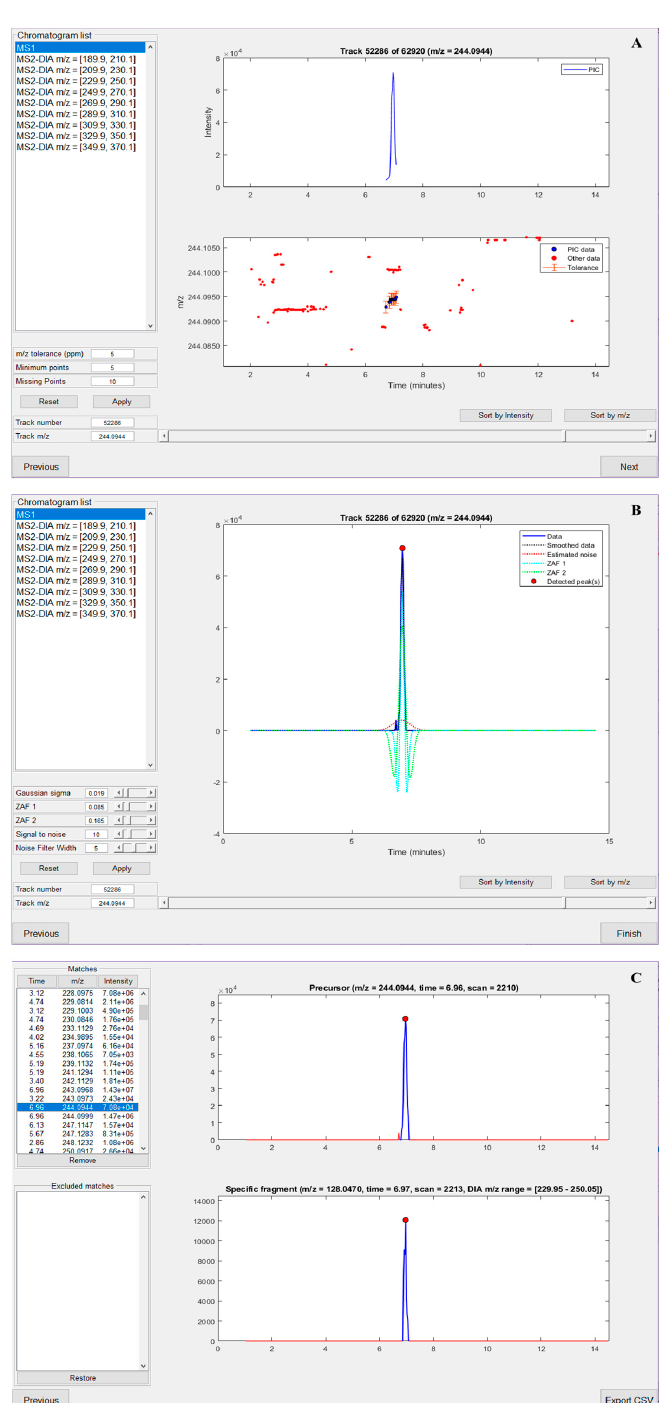
Figure 3. nLossFinder GUI sections (illustrated for analyzing the adduct 5-OH-dC). ( A ) Pure ion chromatogram (PIC) extraction parameters setup. ( B ) Zero-area filter (ZAF) peak detection parameters setup. ( C ) Analysis of processed results.